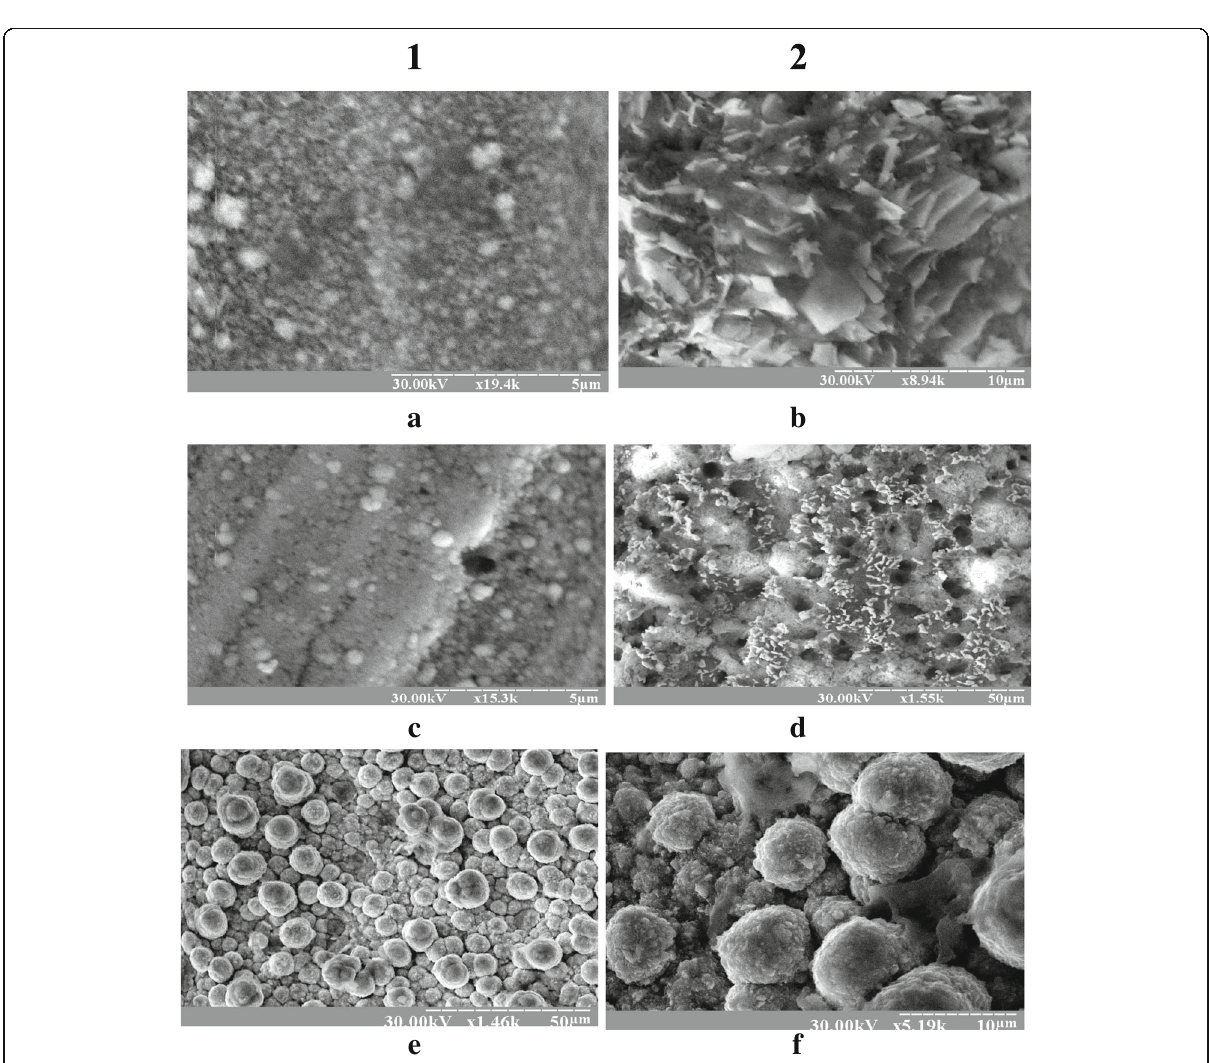
Fig. 5 Appearance of the Rh nanocomposites at the surface of Fe ( a , b ), Cu ( c , d ), and Mo ( e , f ) after electrolysis in ( 1 ) carbamide- and ( 2 ) acetamide-chloride melt with the soluble Rh anode (obtained using REM-101 microscope)